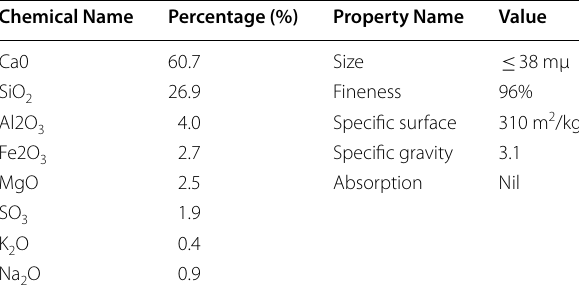
Table 3 Properties of waste glass.